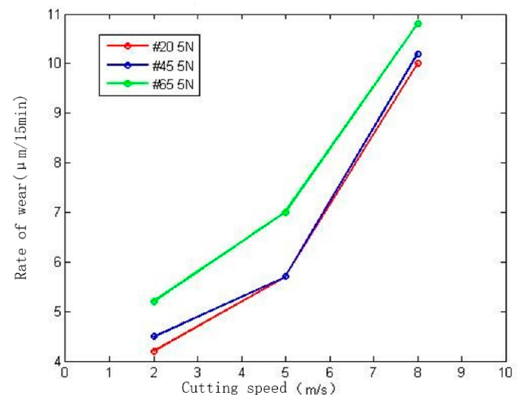
Figure 12. Effect of grinding speed on rate of wear.